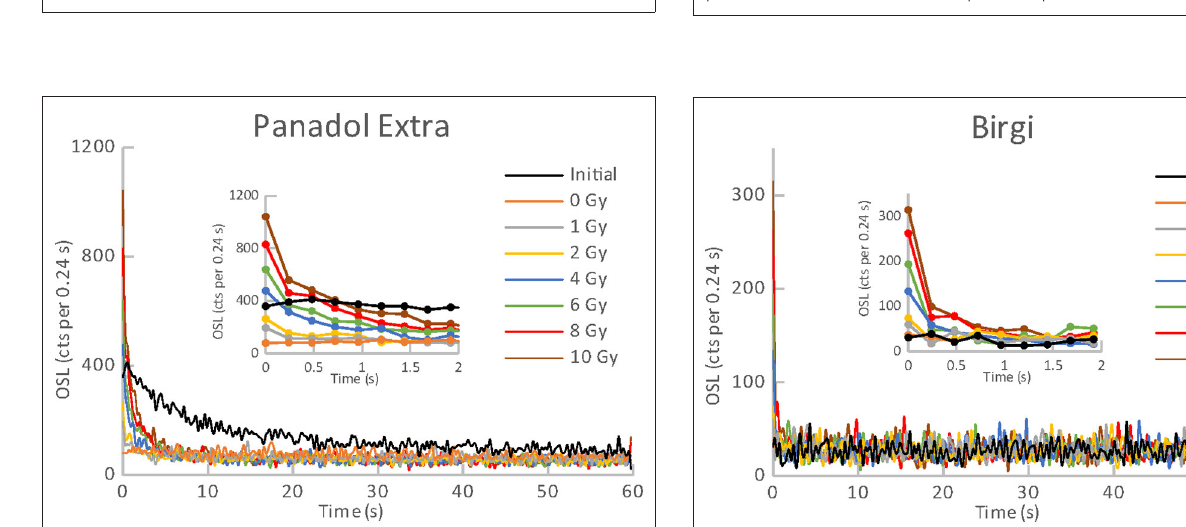
FIGURE 3 | OSL curves for the initial readout and subsequent post-irradiations readouts of an aliquot of Ibuprofen.